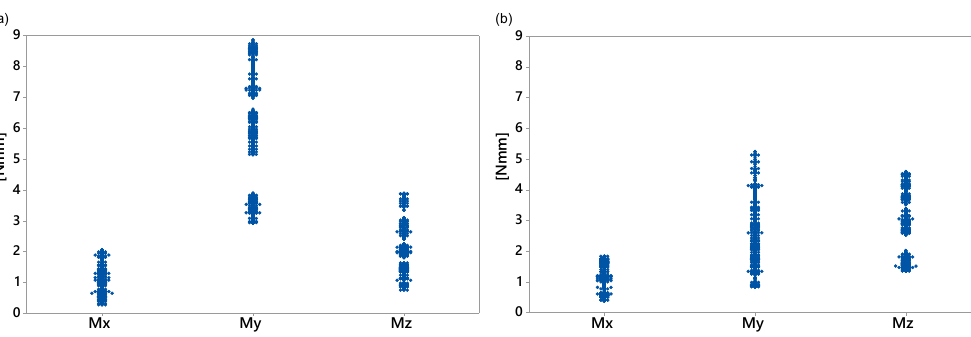
Figure 11. Maximum forces transmitted to housing by gasket. ( a ) middle load; ( b ) counter load.